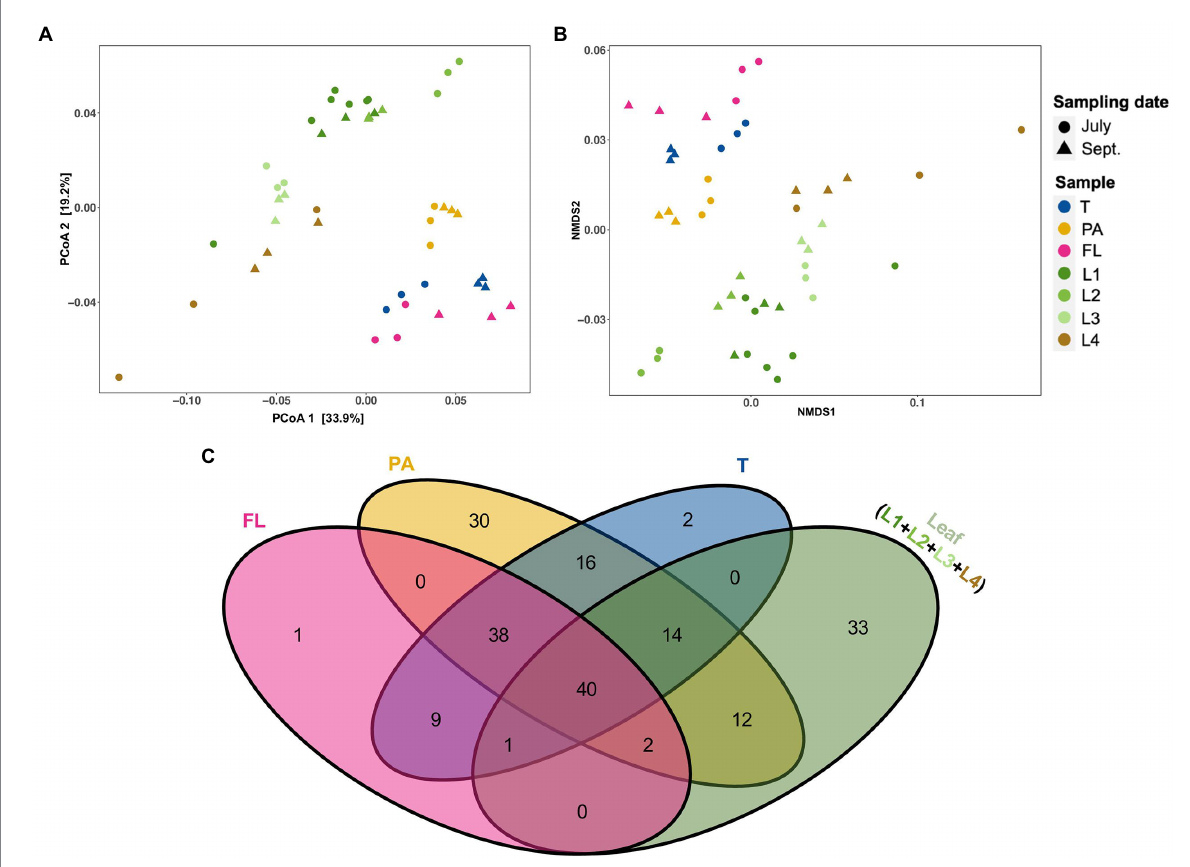
FIGURE 3 The relationship among eelgrass phyllosphere (differently aged and decayed leaves) and seawater microenvironment (i.e., T, PA, and FL fractions) microbiota. (A) Principal coordinates analysis (PCoA) and (B) nonmetric multidimensional scaling (NMDS) of microbial communities based on weighted UniFrac distances matrices showing the structural differences of microbial communities among phyllosphere and seawater microenvironments. Samples are colored by sample type (eelgrass surrounding water: T, PA, and FL fractions and leaves: L1–L4), with different shapes for sampling date (July, September). (C) Venn diagrams showing the unique and shared genera among the phyllosphere and surrounding water microenvironment. T, total (PA + FL); PA, particle-associated; FL, free-living; (L1–L3), differently aged leaves; L4, decayed